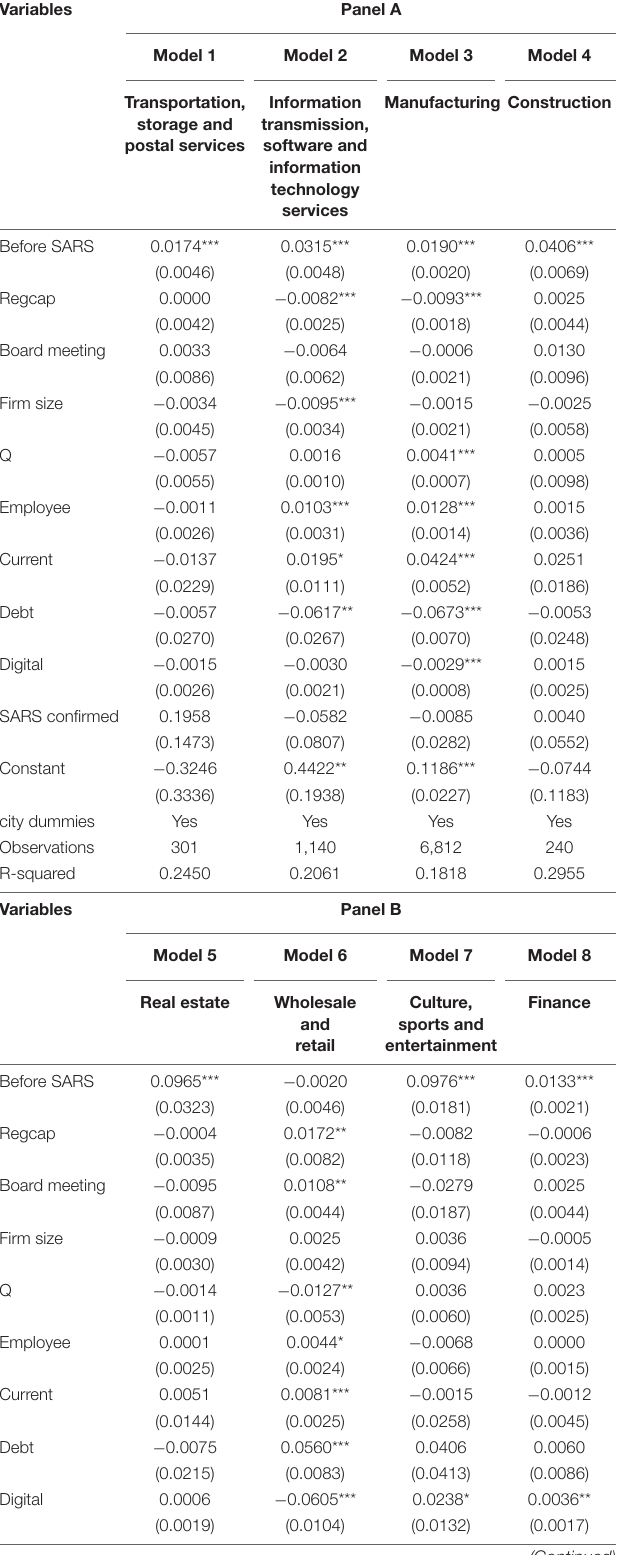
TABLE 7 | The impact of SARS imprint on the recovery of enterprises in different industries.